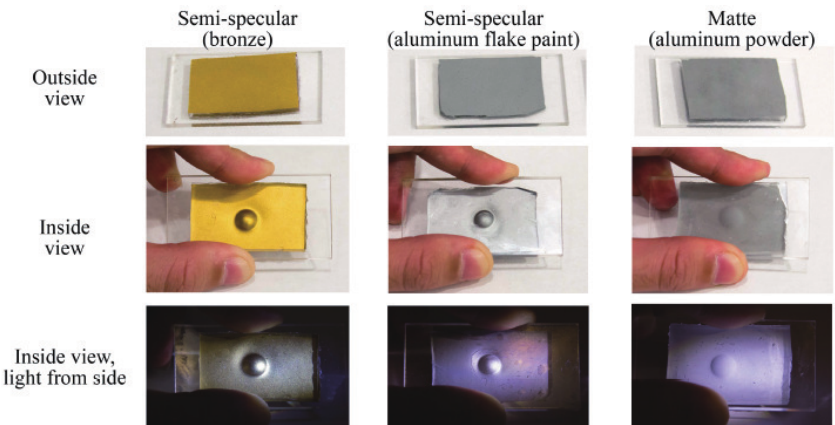
Figure 5. Comparison of appearance of tactile skin with three different reflective membranes used in GelSight tactile sensor developed by an MIT research group [40]. Three kinds of elastomer coatings: Semi-specular coating painted by bronze flake and aluminum flake paint, and matte coating by aluminum powder. In the second and third row, the three pieces of elastomer are pressed against a ball with diameter 6 mm, but the in the third row, the elastomer is illuminated by light from the side direction [40]. (Source: W. Yuan, S. Dong, and E. H. Adelson, “GelSight: High-Resolution Robot Tactile Sensors for Estimating Geometry and Force,” Sensors , 17, 2017